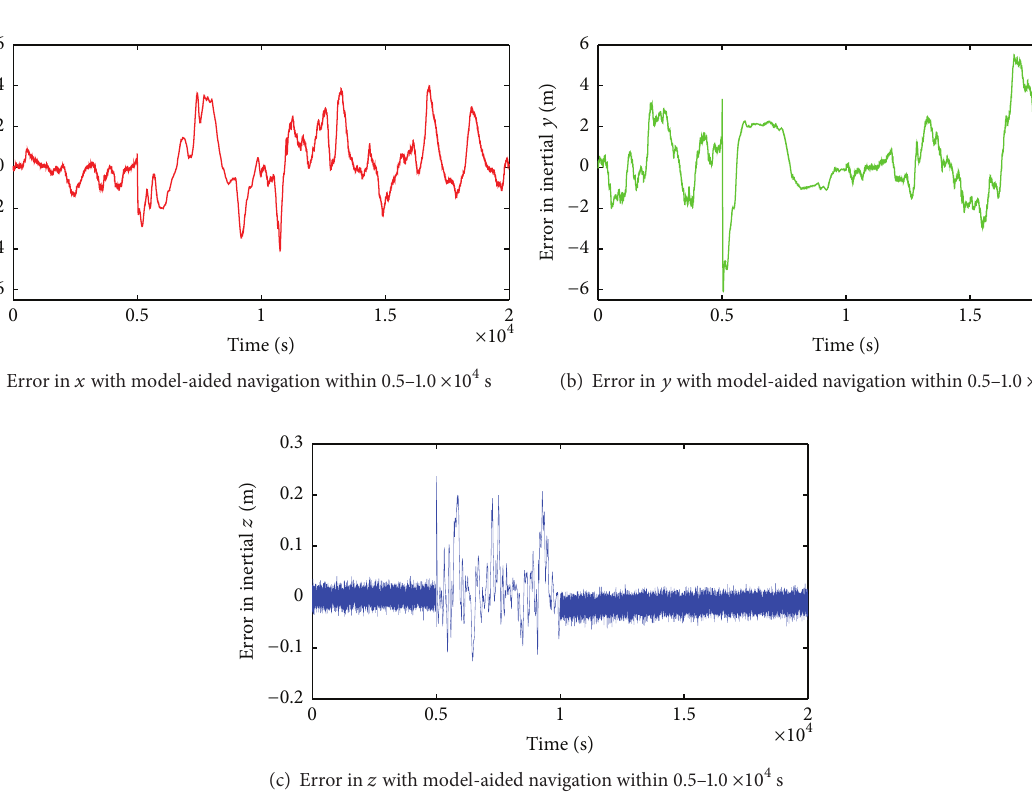
Figure 7: Errors of 𝑥,𝑦,𝑧 in model-aided navigation within 0.5–1.0 ×10 4 s (A to B) in Figure